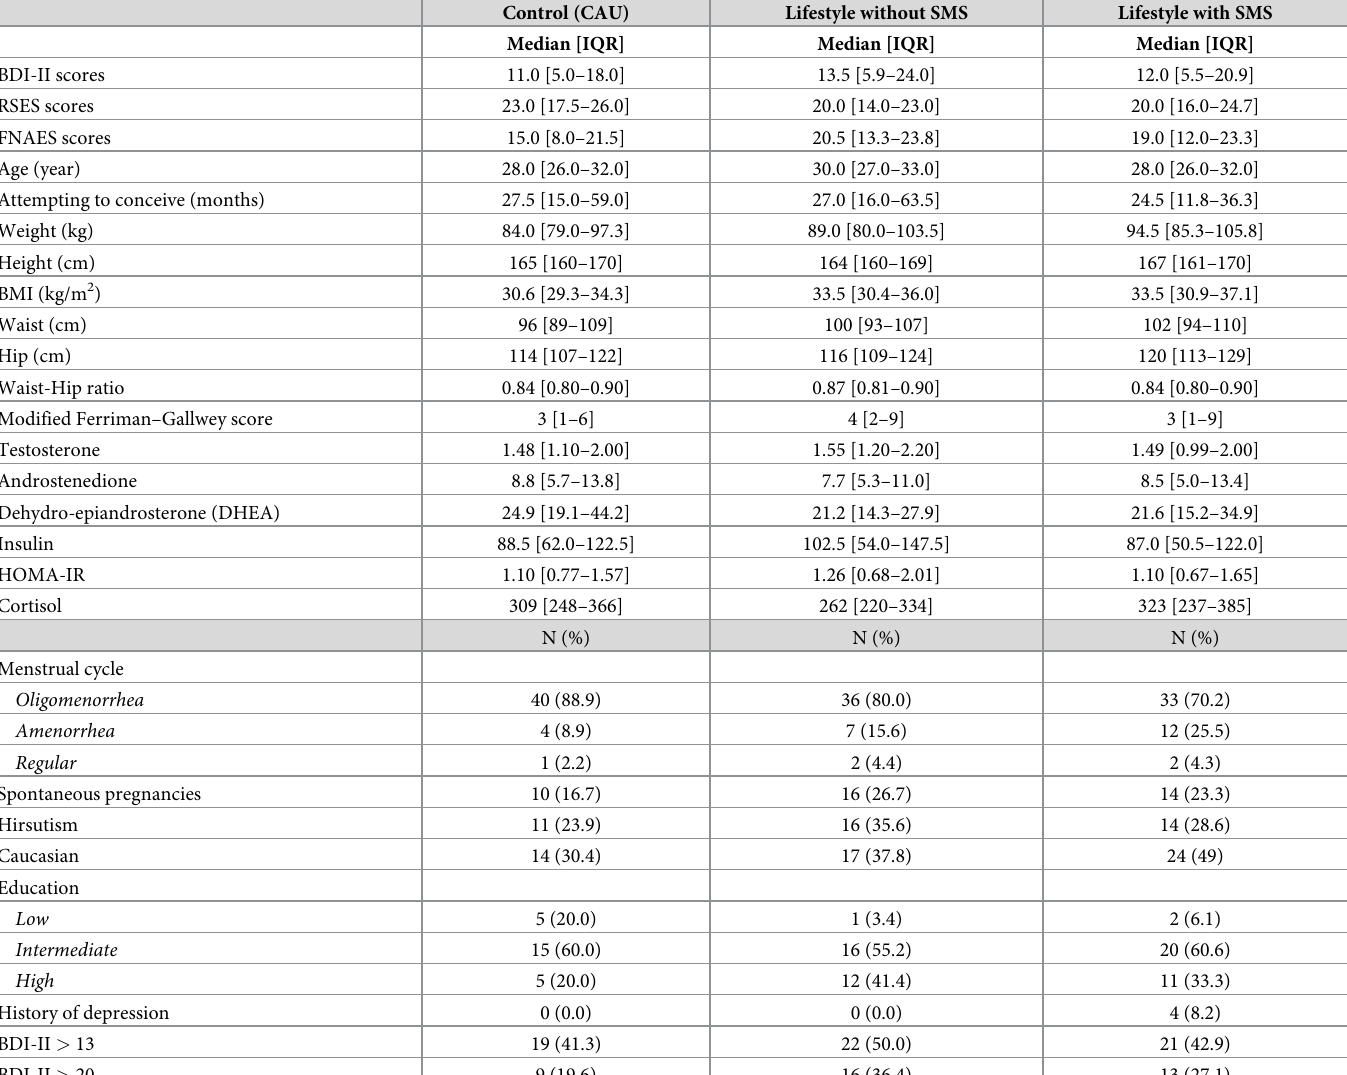
Table 1. Baseline characteristics by trial group. IQR = Interquartile range, BDI-II = depression, RSES = self-esteem, FNAES = body image. Spontaneous pregnancies observed during the study